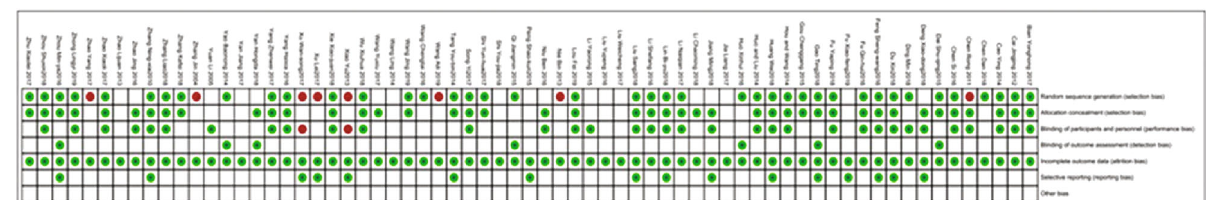
Figure 3: Risk of bias assessment in eligible studies. The quality assessment was conducted by Review Manager 5.3 according to the Cochrane Handbook for Systematic Reviews of Interventions Version 5.1.0. Red circle: high risk of bias; green circle: low risk of bias; blank: unclear risk of